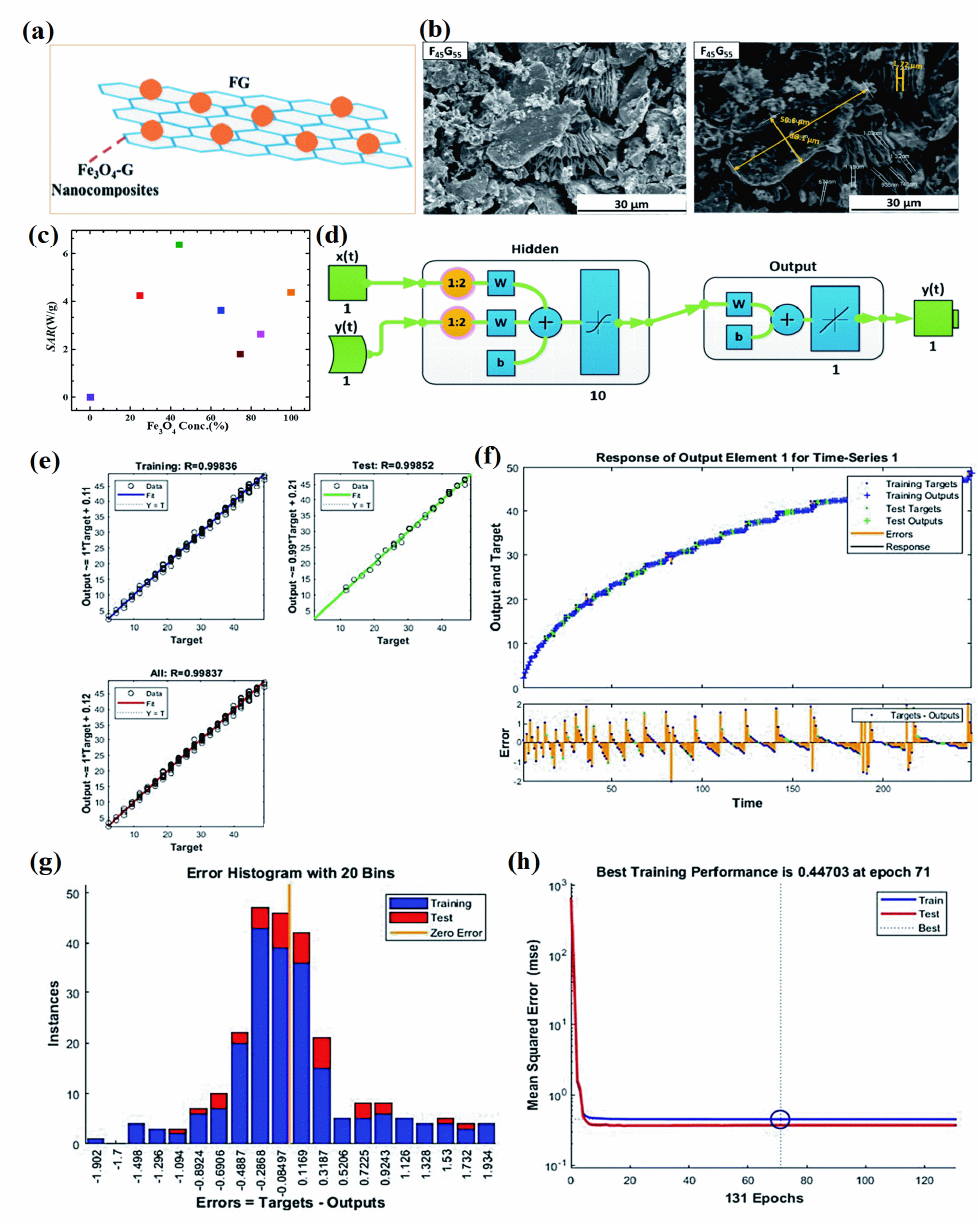
Figure 10. ( a ) Schematic illustration of Fe 3 O 4 ‐ G, ( b ) SEM images of F 45 G 55 , ( c ) SAR values of Fe 3 O 4 ‐ G with different compositions, ( d ) neural network architecture, ( e ) the output and target correlation for sample F 45 G 55 , ( f ) time series response curves with time instances on the x ‐ axis and predicted versus observed values on the y ‐ axis, ( g ) error histogram with 20 bins, and ( h ) performance plot of MSE versus epoch count. Reprinted from Ref. [226]. Creative Commons license.